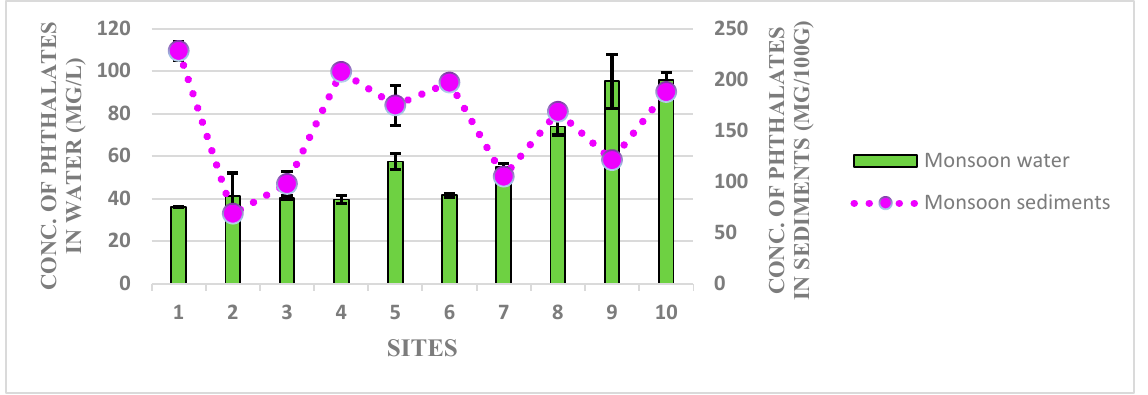
Figure 4. Phthalate distribution in the monsoon season of water (bar plot) and sediments (line) of Harike wetland.